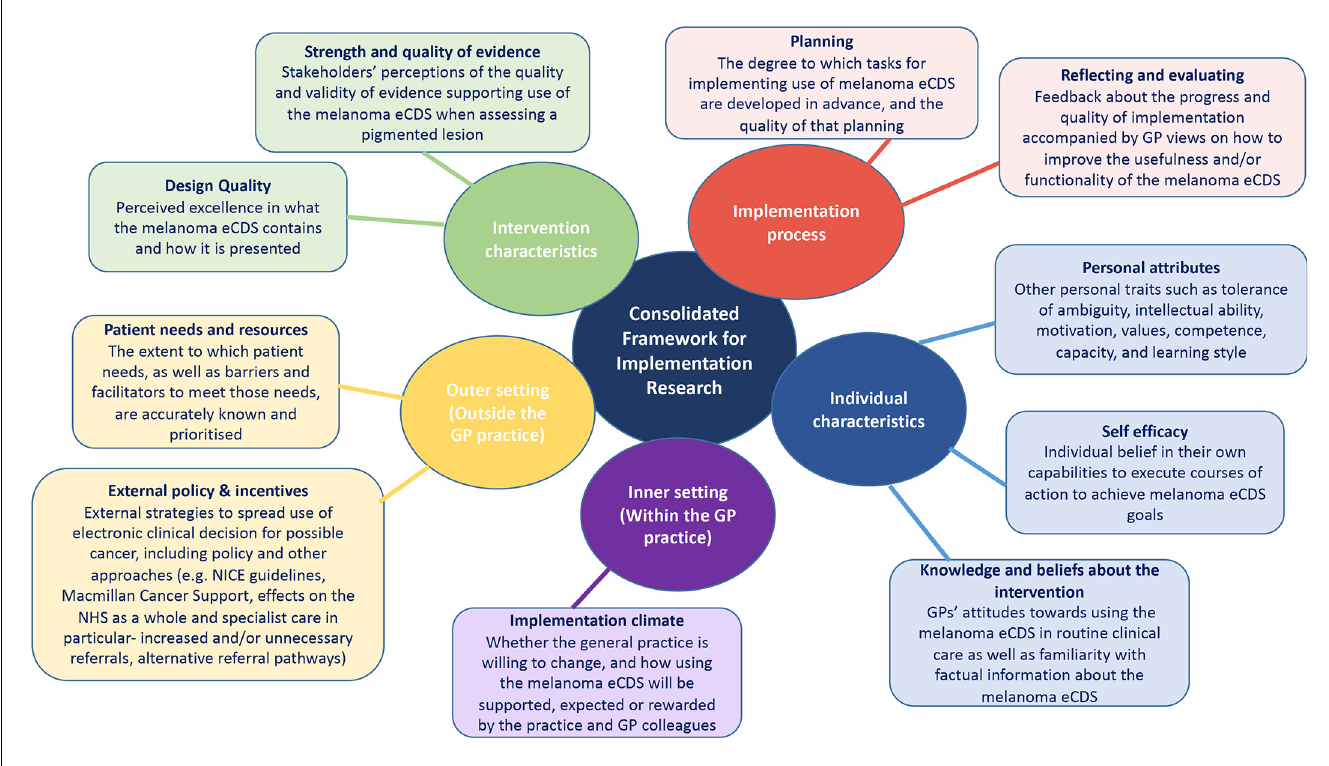
Figure 2. Overview of the Consolidated Framework for Implementation Research as applied to eCDS tools. eCDS = electronic clinical decision support.